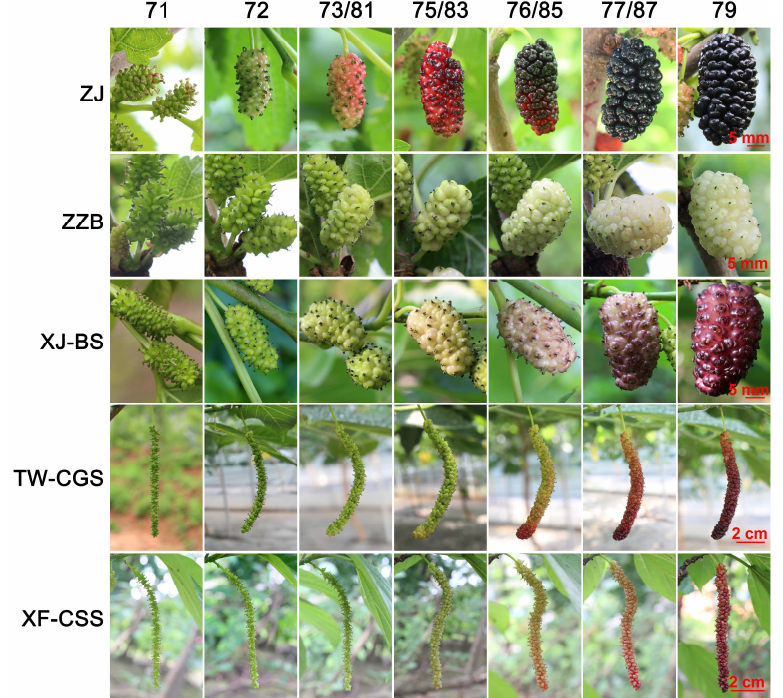
Figure 6. Stages of fruit development and maturity for mulberry according to the BBCH scale.